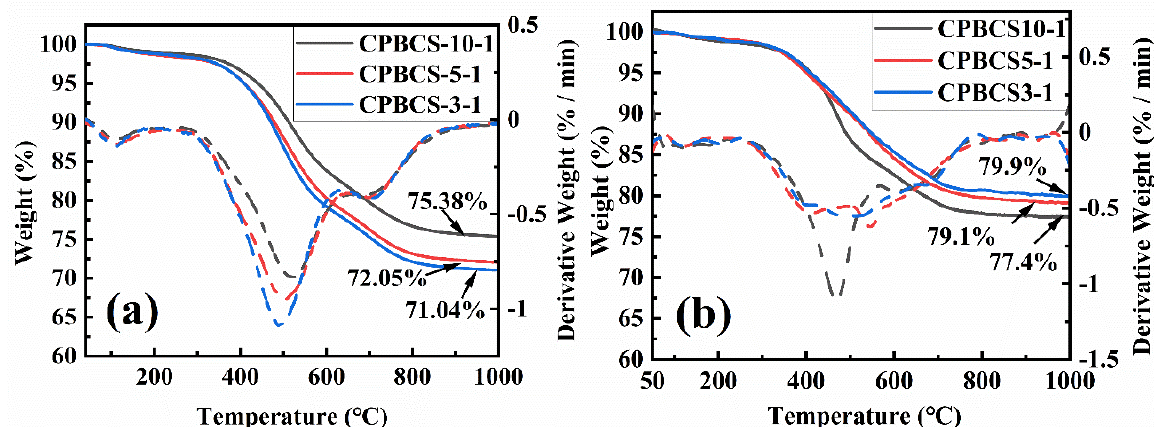
Figure 7. TG-dTG (derivative of TG curves) curves of CPBCSs: CPBCS3-1, CPBCS5-1, and CPBCS10-1 in argon ( a ) and in air ( b ).